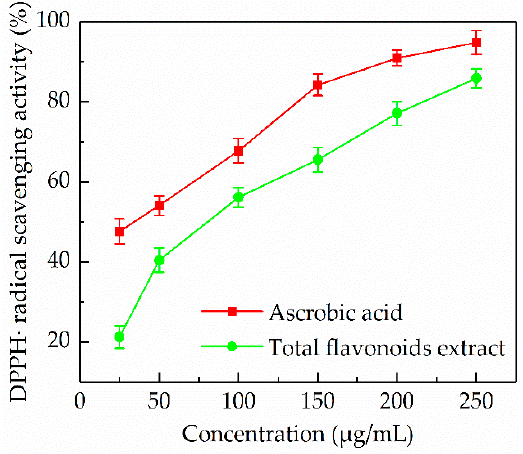
Figure 4. Scavenging activity of P. cretica extract obtained by optimized ultrasound-assisted extraction against DPPH• radical compared with ascorbic acid.